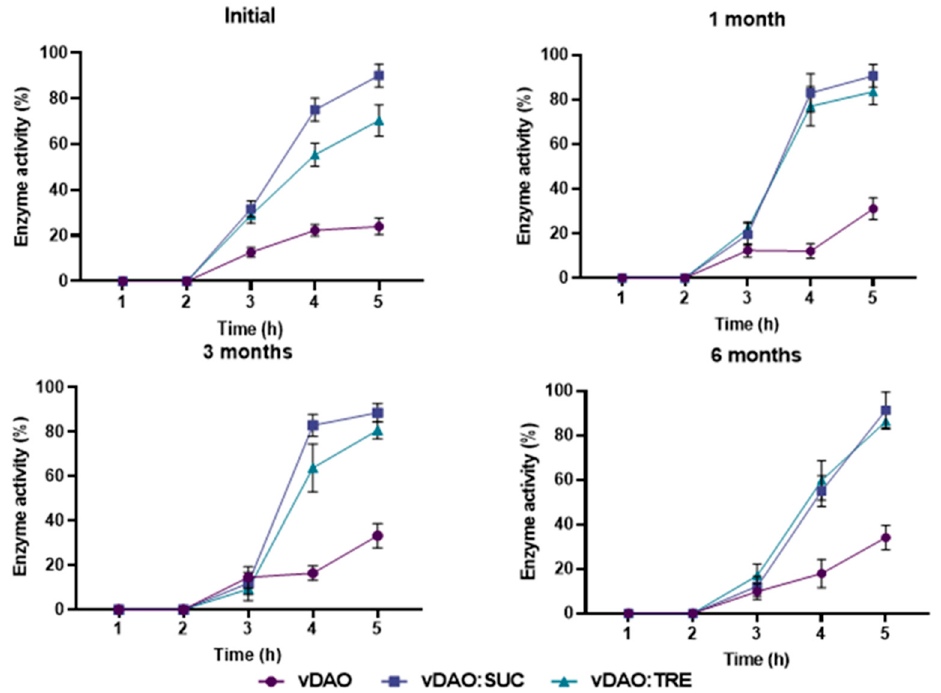
Figure 6. Release profiles of vDAO with and without cryoprotectants from monolithic tablets stored for 6 months at 4 °C. For the dissolution patterns, tablets were incubated at 37 °C 100 rpm in SGF (2 h) followed by SIF (3 h). At the indicated times, aliquots were withdrawn, and vDAO activity was determined by the DCHBS-AAP-HRP method. Reported values of vDAO activity refer to the enzymatic activity in the incubation media (mean ± SD; n = 3 different experiments).